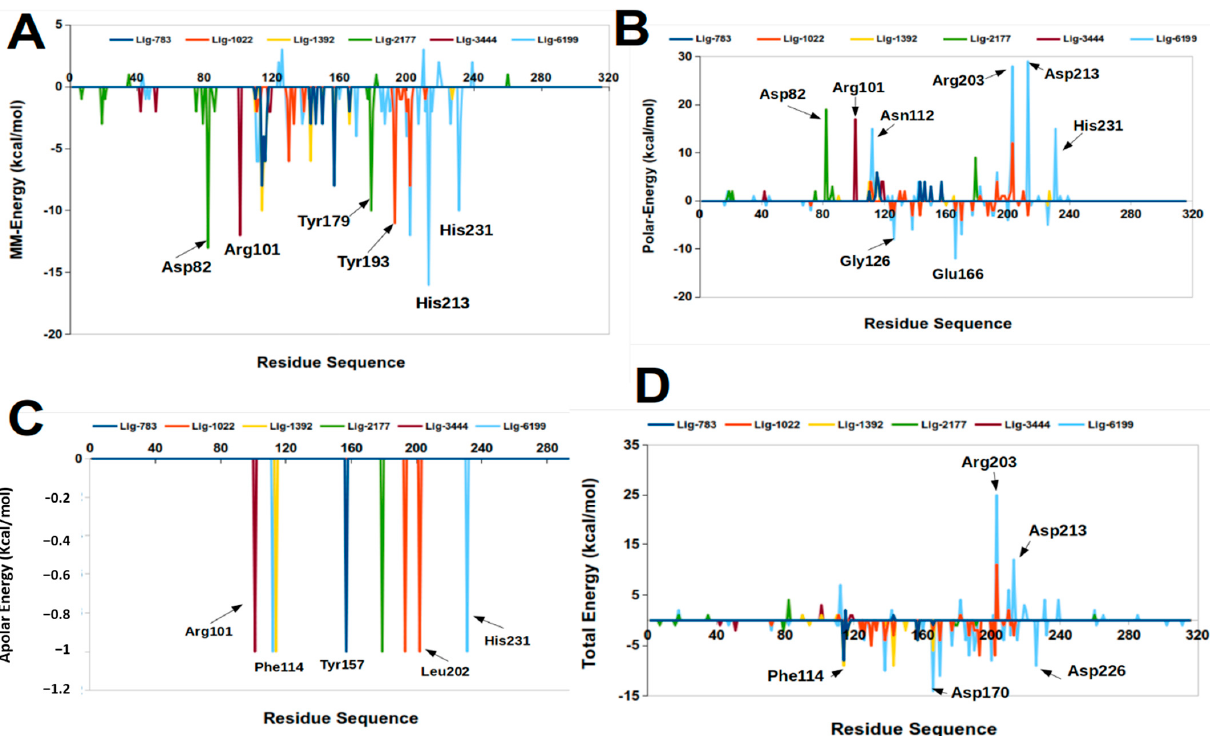
Figure 9. Decomposition of the binding free energy per residue on the thermolysin pocket. ( A ) represent the MM-Energy contribution. ( B ) represent the polar energy contribution. ( C ) represent the apolar energy contribution and ( D ) represent the total energy